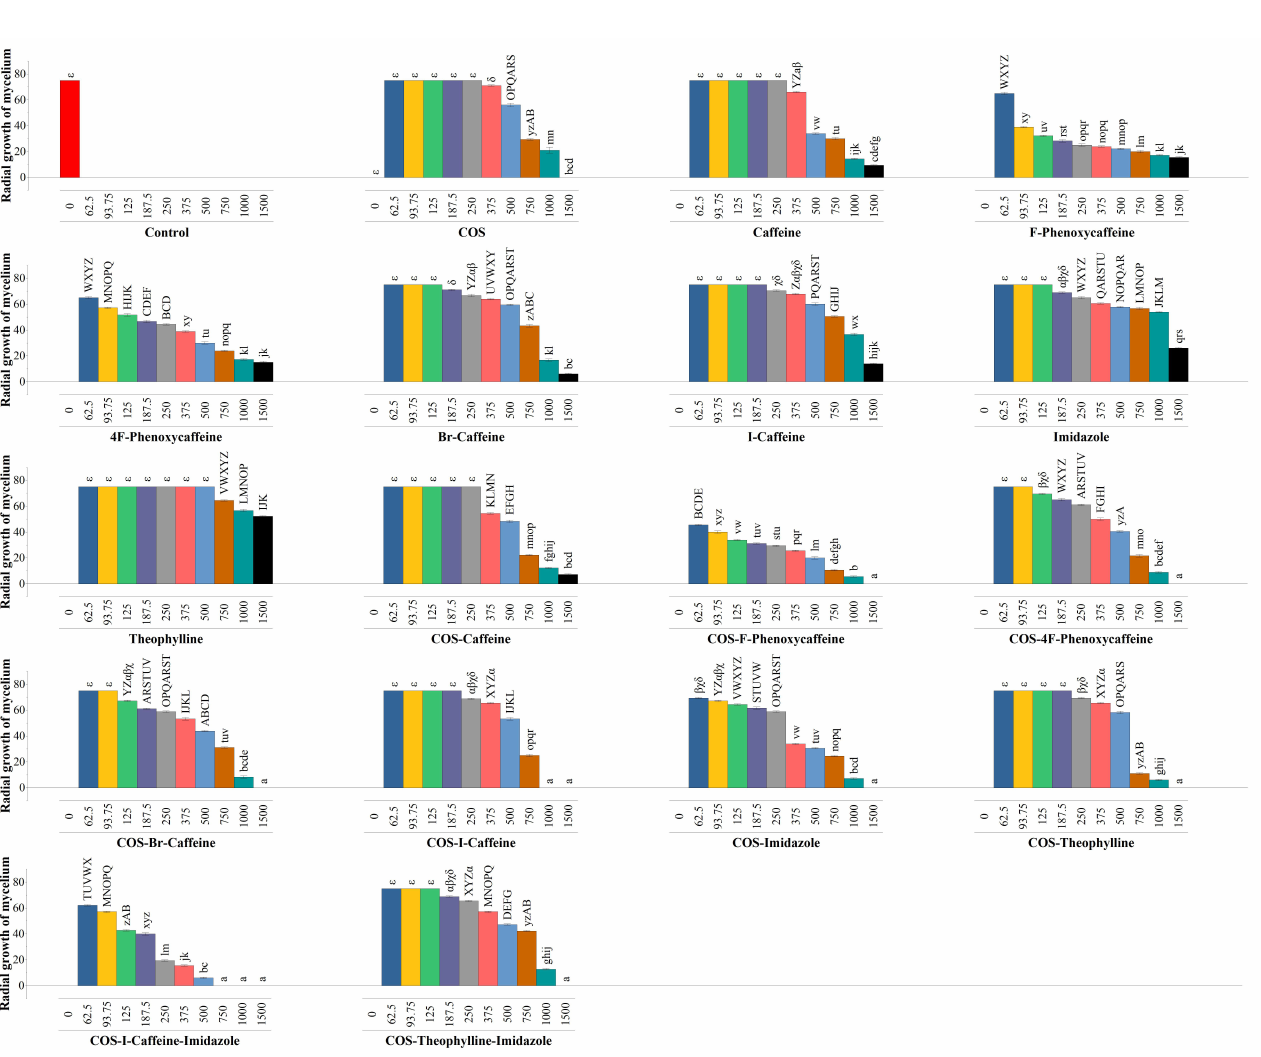
Figure 6. Mycelial growth inhibition of N. parvum by caffeine, its derivatives, imidazole, and theo- phylline, their respective COS–conjugated complexes, and some selected ternary combinations with imidazole at different concentrations (ranging from 62.5 to 1500 µ g mL − 1 ). Error bars repre- sent standard deviation. Treatment–concentration combinations accompanied by the same letters are not significantly different at p < 0.05 according to Tukey’s HSD test after a two-way ANOVA (Tukey’s HSD lettered grouping follows the sequence a–z, A–Z, α – ε , where ‘a’ indicates the group of treatment–concentration combinations with the highest efficacy and ‘ ε ’ the group of least effective treatment–concentration